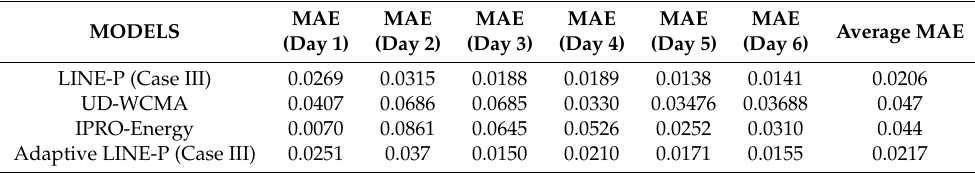
Table 12. Error comparison of the energy prediction models in terms of MAE for the solar energy